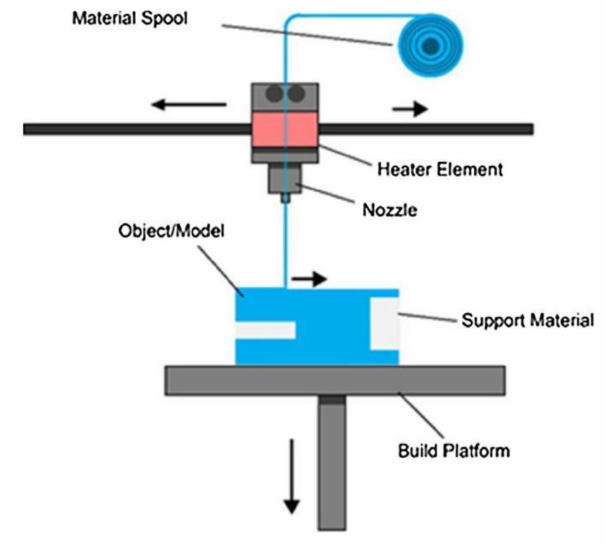
Figure 1. The principle of fused filament fabrication process. Reprinted with permission from [12]. Copyright 2018,